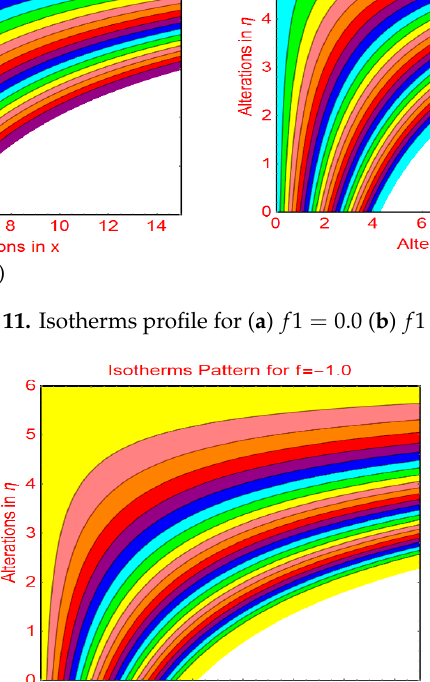
Figure 12. Isotherms profile for f 1 = − 1.0.